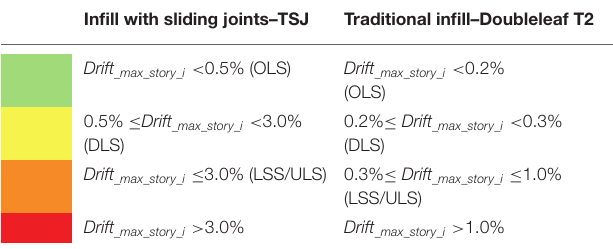
TABLE 5 | Performance levels of the infills (from Hak et al., 2012; Morandi et al., 2018b ). Infill with sliding